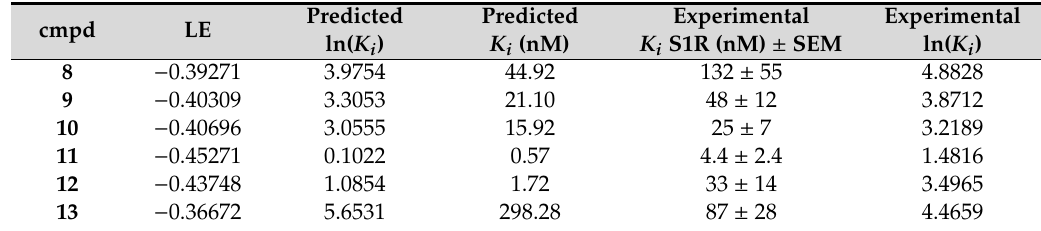
Table 3. LE, predicted and experimental binding a ffi nities of compounds 8 – 13 toward S1R binding